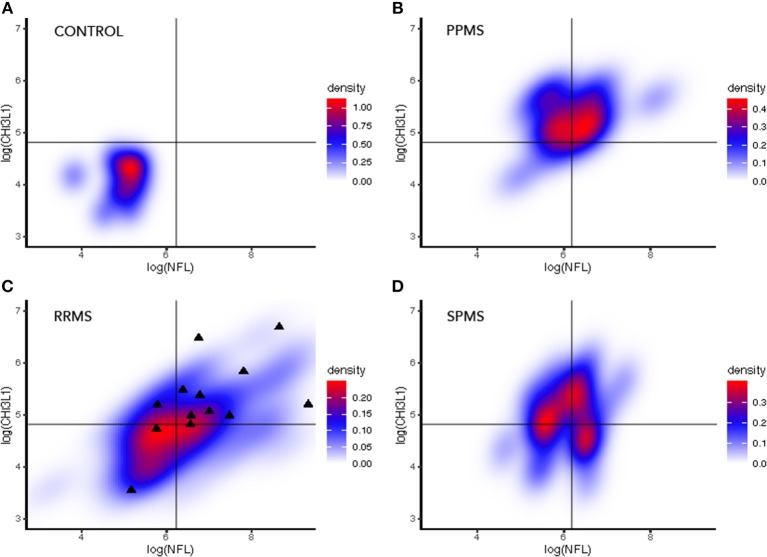
Density maps representing paired NFL and CHI3L1 values in CSF of non-MS controls and MS patients. The black lines in each diagram represent the median log values of CSF NFL and CHI3L1 in the whole cohort. Note that each subgroup has the peak density of patients in a different position in reference with the median log values. (A) In non-MS control group, almost all patients fell in the left-inferior quadrant. (B) In PPMS subgroup, CHI3L1 levels were over the median in almost all patients, and two groups were distinguished with regards to NFL levels. (C) In the RRMS group, black triangles represented patients that at the end of the observation period evolved to progressive disease. (D) SPMS patients constitute an intermediate density map with three regions of distribution. NFL, neurofilament light chain; CHI3L1, chitinase-3-like-1; RRMS, relapsing-remitting multiple sclerosis; SPMS, secondary progressive multiple sclerosis; PPMS, primary progressive multiple sclerosis; Switch, diagnosis of SPMS during follow-up.